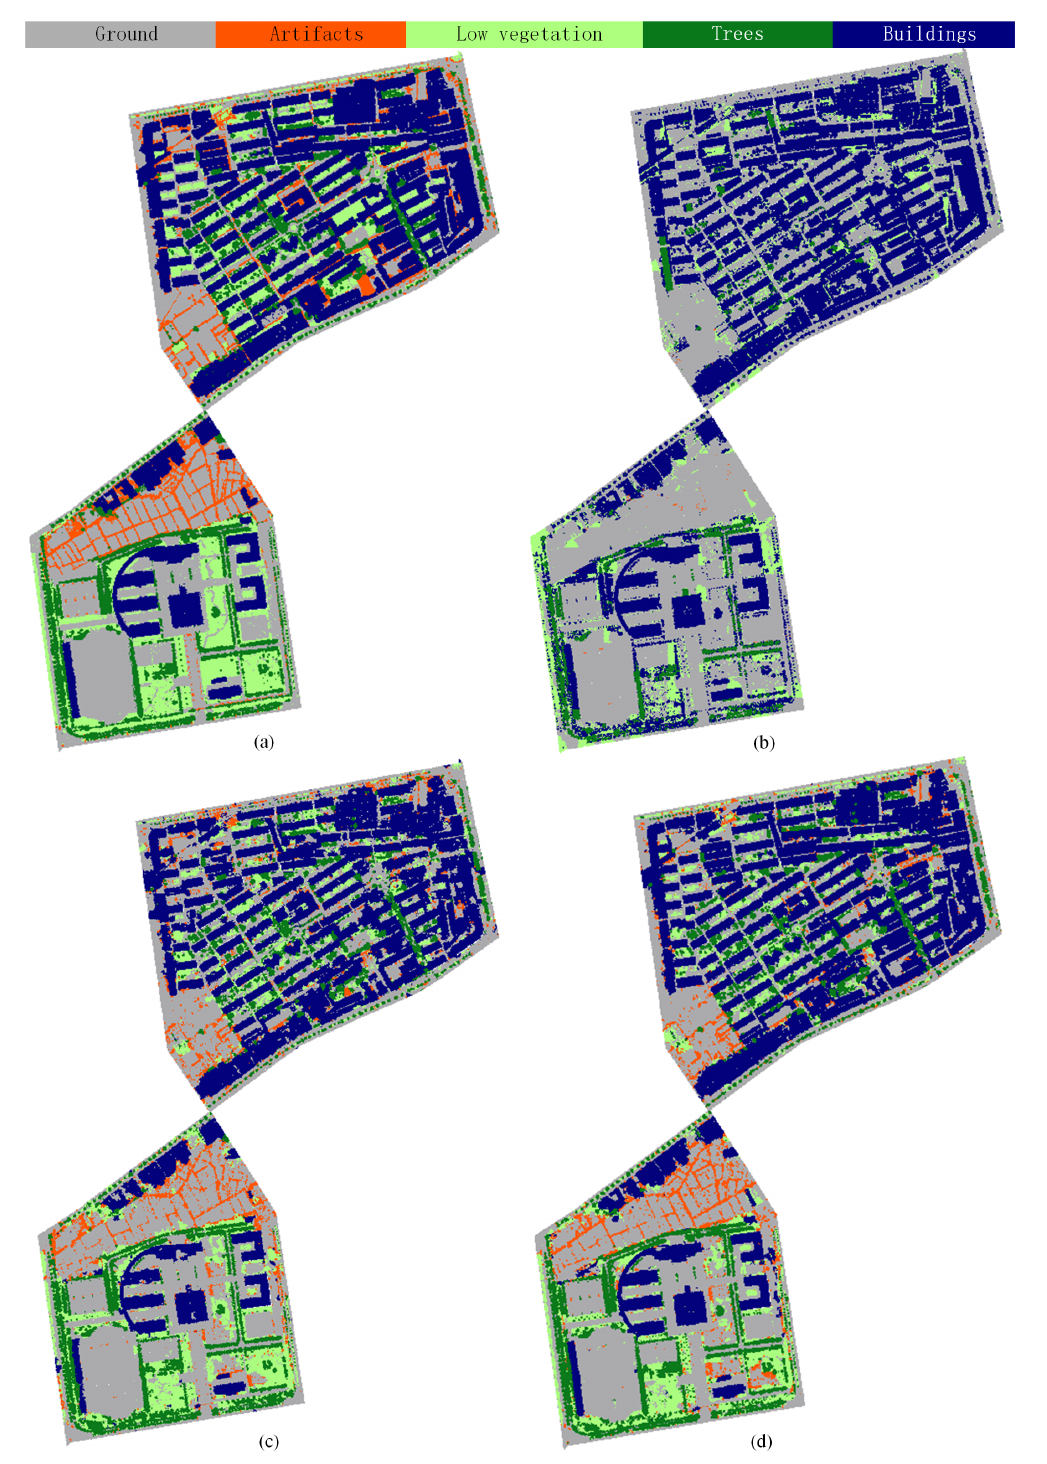
Figure 14. Classification results using the LASDU dataset (no intensities) with different semantic labeling methods. ( a ) Ground truth, ( b ) PointNet, ( c ) PointNet++, and ( d )